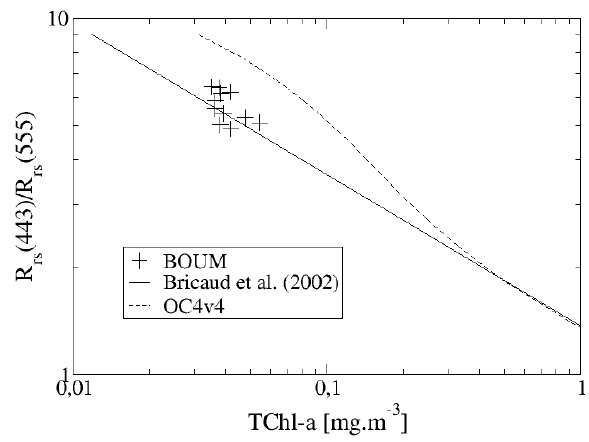
Figure 8. Fig. 8. Variations of the blue-to-green reflectance ratio as a function of the TChl- a concentration for the BOUM data set. The dashed line represents the global NASA algorithm (“OC4v4,” see O’Reilly et al., 1998), and the solid line the regional algorithm developed by Bricaud et al.